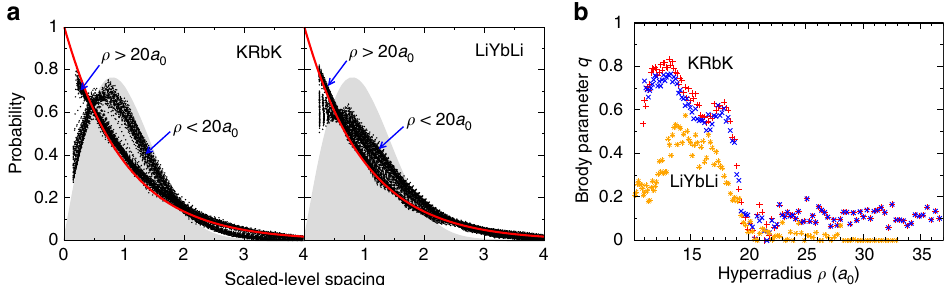
Figure 5 | Statistical analysis of the short-range adiabatic potentials. ( a ) Distribution of nearest-neighbor spacings of J ¼ 0 KRbK and LiYbLi adiabatic potential energies in hyperspherical coordinates. Each black, dotted curve corresponds to the distribution for a single hyper radius r as a function of scaled level spacing. The shaded grey area and red curve are Wigner–Dyson and Poisson distributions, respectively. For both KRbK and LiYbLi we use the full trimer potential. ( b ) The Brody parameter q as a function of hyper radius for both KRbK and LiYbLi as derived from the data in ( a ) for the full trimer potential and data for KRbK based on the pair-wise potential. Blue and red markers correspond to distributions for KRbK obtained with the full and pairwise electronic potentials, respectively, whereas the orange markers for LiYbLi are obtained with the full potential. For q - 0 the distribution approaches the Poisson distribution while for q - 1 it approaches the